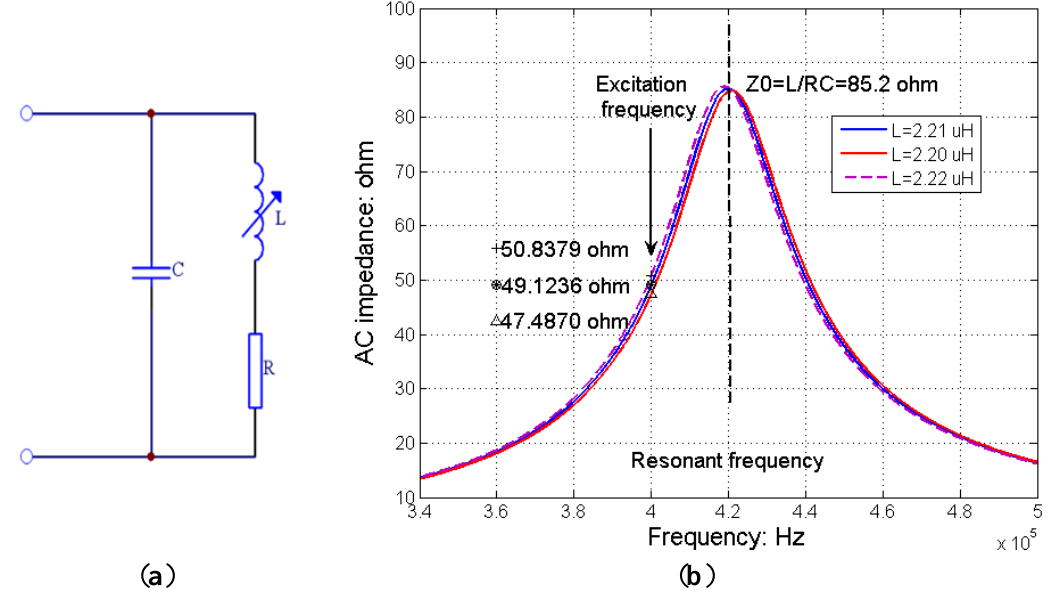
Figure 3. The structure of a parallel LC sensing unit and the impedance-frequency relationship of the transducer with variable inductance. ( a ) A parallel LC sensing unit; ( b ) Transfer function of the LC sensing